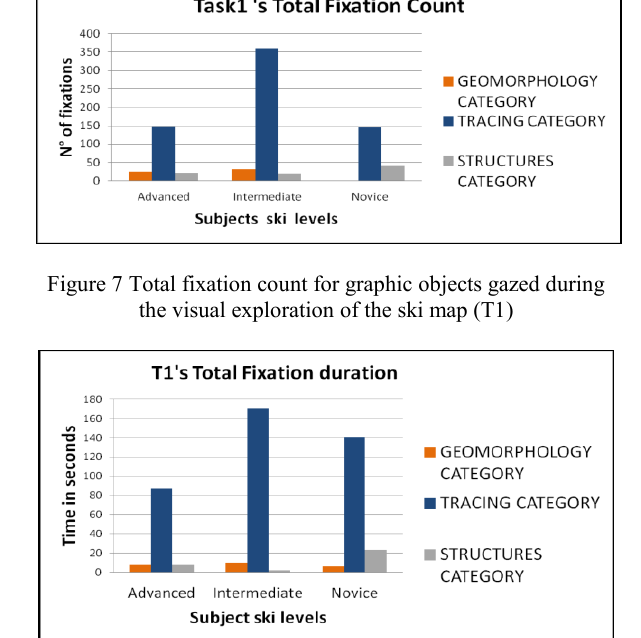
Figure 8 Total fixation duration for graphic objects gazed